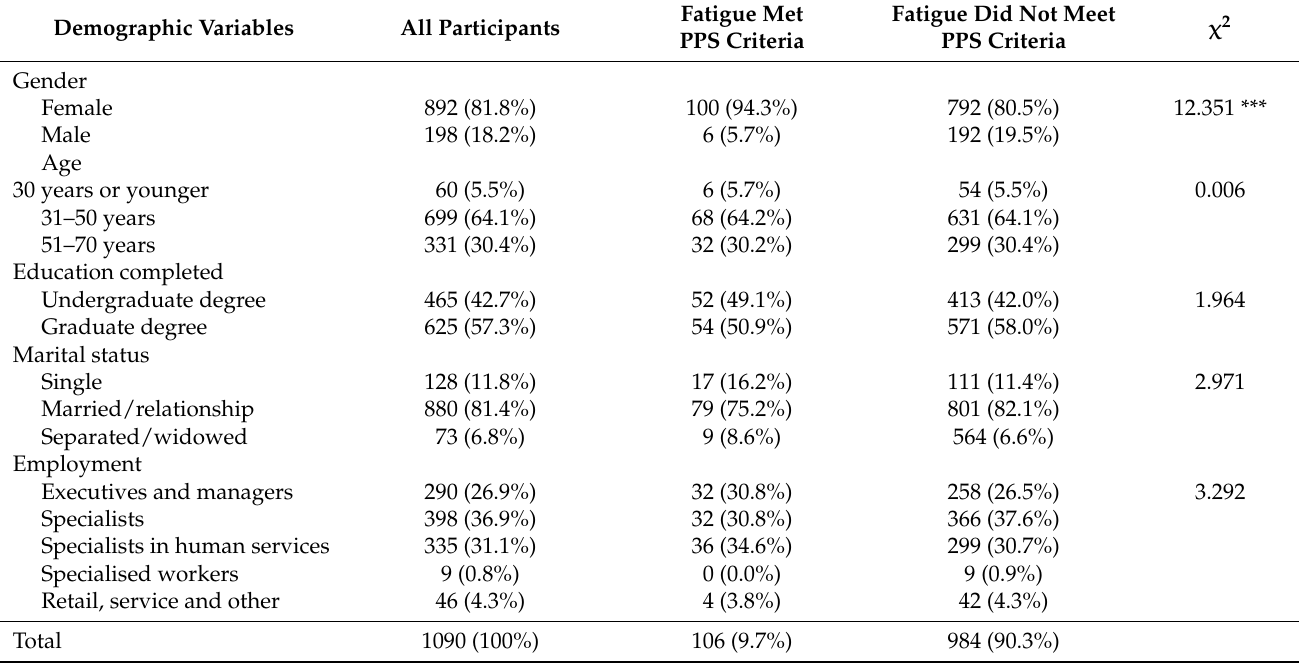
Table 1. Demographic characteristics of participants whose fatigue met or did not meet persistent physical symptom (PPS)